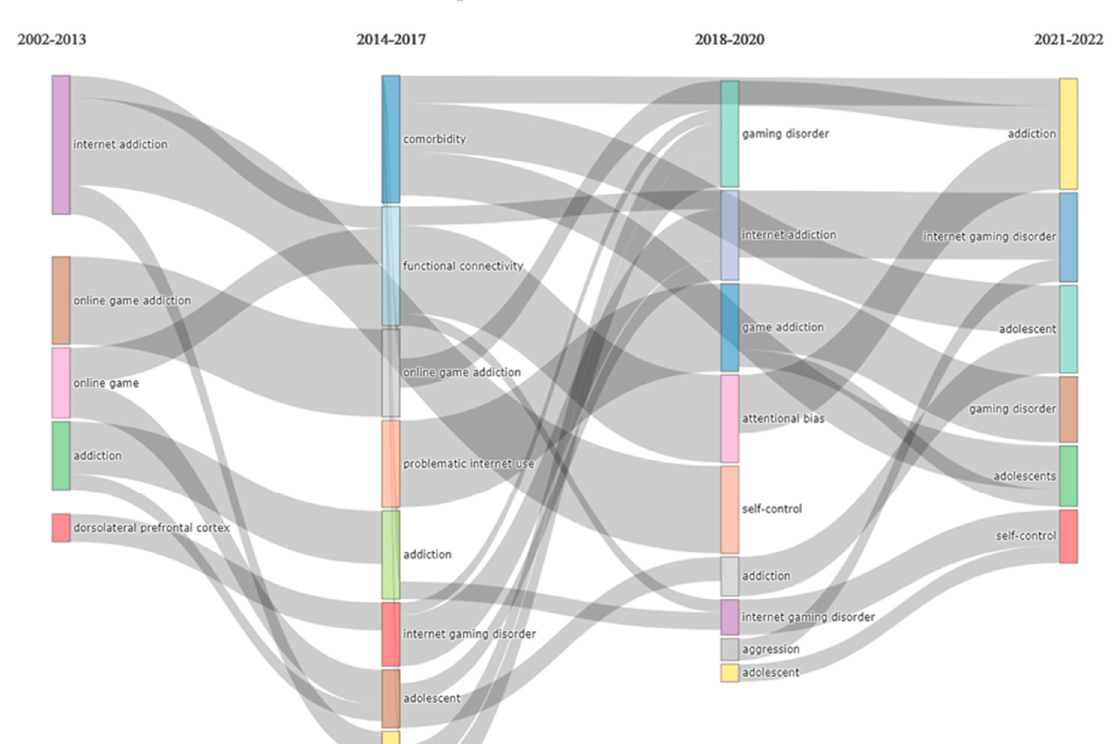
Figure 7. Overview of the evolution of themes across the years.